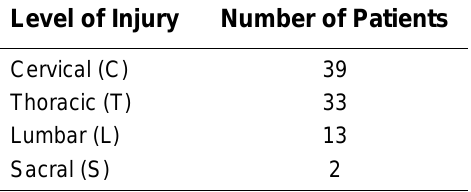
Level of Injury of Spinal Cord Injury Patients, Group